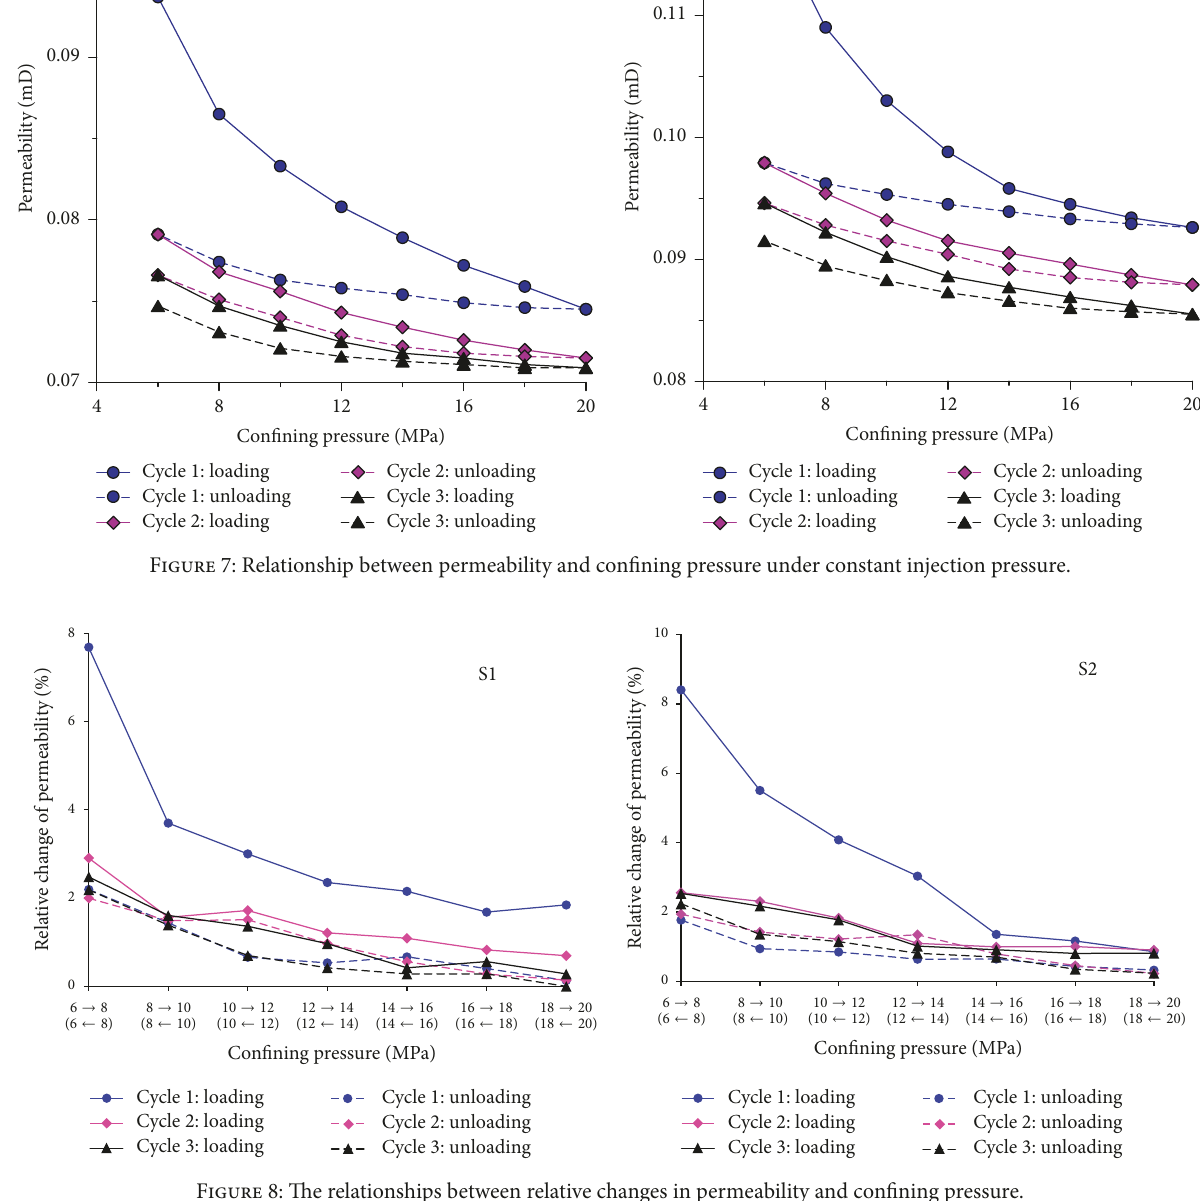
Figure 8: The relationships between relative changes in permeability and confining